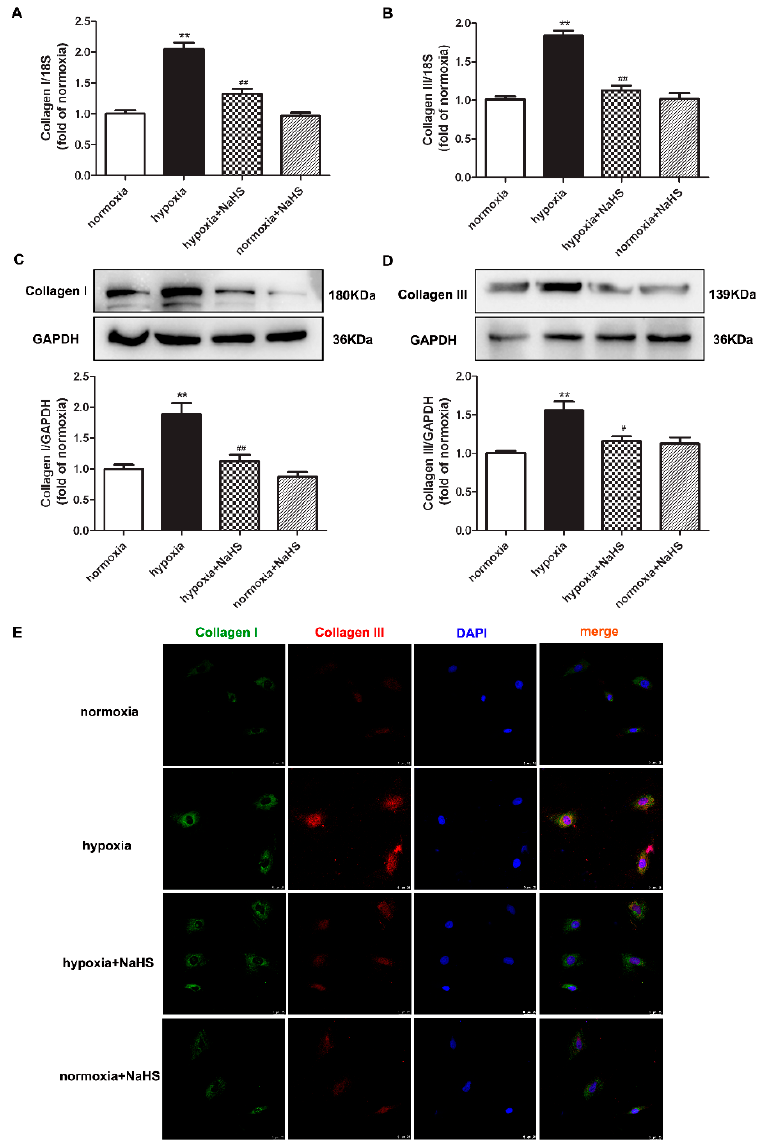
Figure 3. NaHS repressed the collagen synthesis in cardiac fibroblasts with hypoxia. After pre-administration with NaHS (50 µ M) for 4 h, neonatal rat cardiac fibroblasts were subjected to normoxia (containing 5% CO 2 and 95% O 2 ) or hypoxia (containing 5% CO 2 and 1% O 2 ) for 4 h. ( A , B ) The collagen I and collagen III mRNA expression were detected by real-time PCR. ( C , D ) Collagen I and collagen III protein expression were detected by Western blot. ** p < 0.01 vs. normoxia; # p < 0.05, ## p < 0.01 vs. hypoxia, n = 6. ( E ) Collagen I and collagen III were immunofluorescence stained with Alexa Fluor 488 (green) and Cy3 (red) conjugated IgG, respectively. The nuclei were stained with DAPI (blue). Bar = 25 μ m.